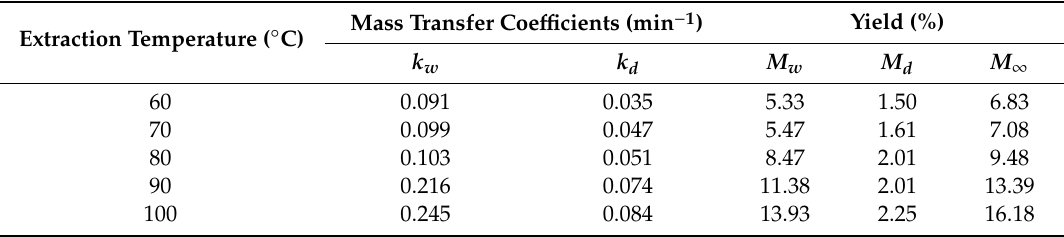
Extraction Temperature ( ◦